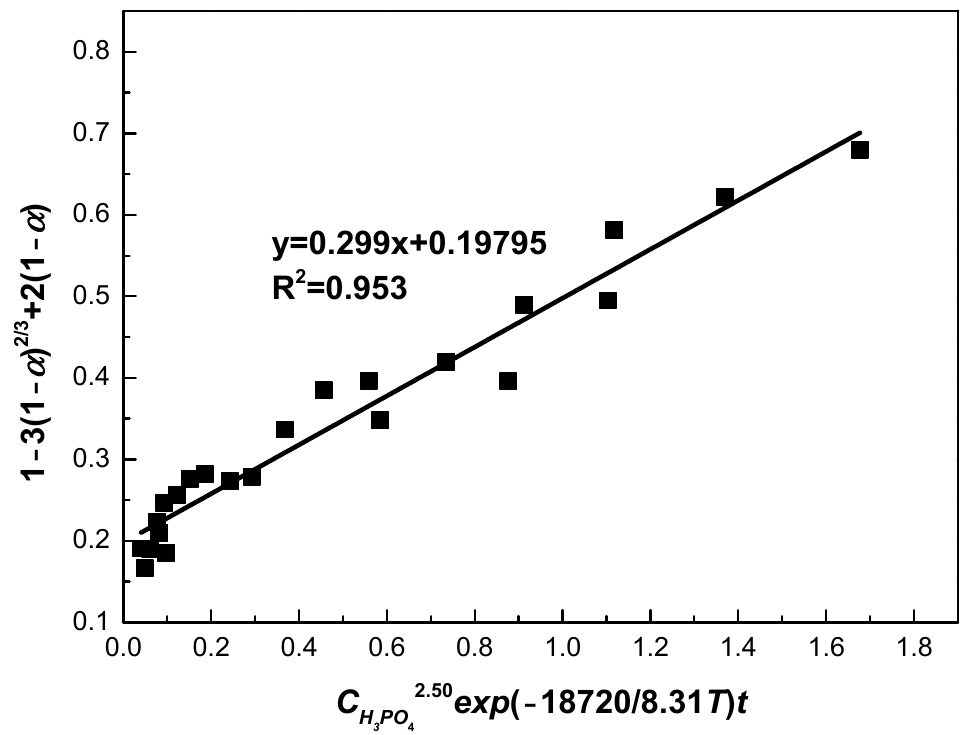
Figure 14. The relationship between 1 − 3(1 − α ) 2/3 + 2(1 − α ) and C H3PO4 2.50 exp ( − 18720/8.31 T ) t .